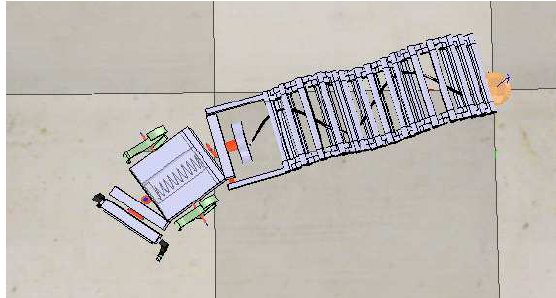
Figure 4. A series of body joints was included to connect the different modules.